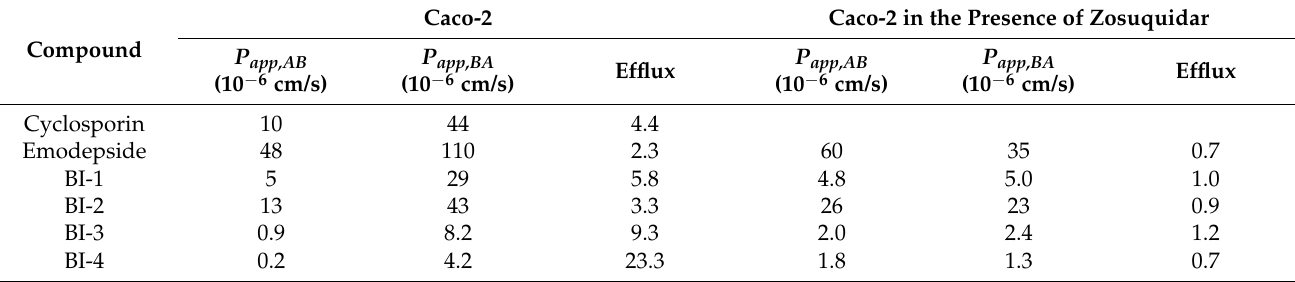
Table 4. Modified bidirectional permeability assay with Caco-2 cells. Data are mean values of duplicates. Final concentration of compounds in donor compartment was 1 µ M.